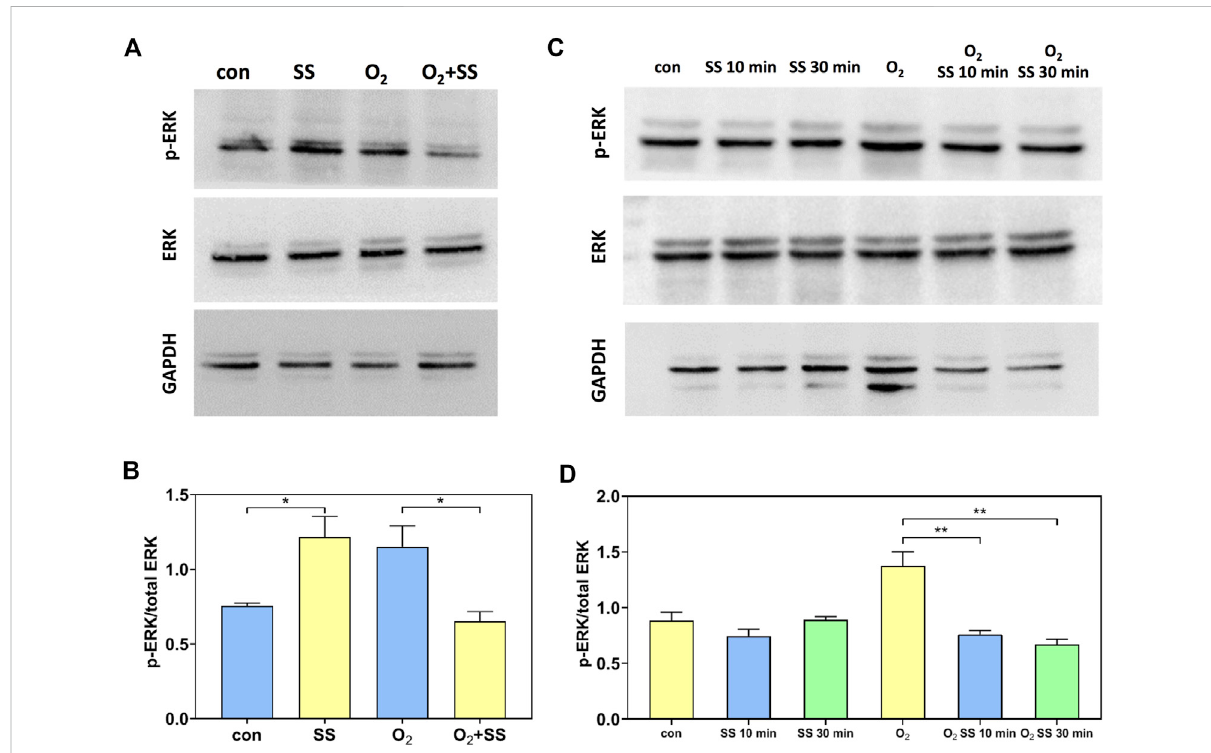
FIGURE 5 Effect of senescence on the extracellular signal-regulated kinase (ERK) and p-ERK expression of PTM cells in response to shear stress. (A,B) Western blot analysis of the p-ERK and ERK expression of normal and senescent PTM cells under static conditions or subjected to 12-h shear stress (* p < 0.05). (C,D) Western blot analysis of the p-ERK/total ERK protein expression of normal and senescent PTM cells under static conditions or subjected to 10-min and 30-min shear stress (** p < 0.01). SS stands for shear